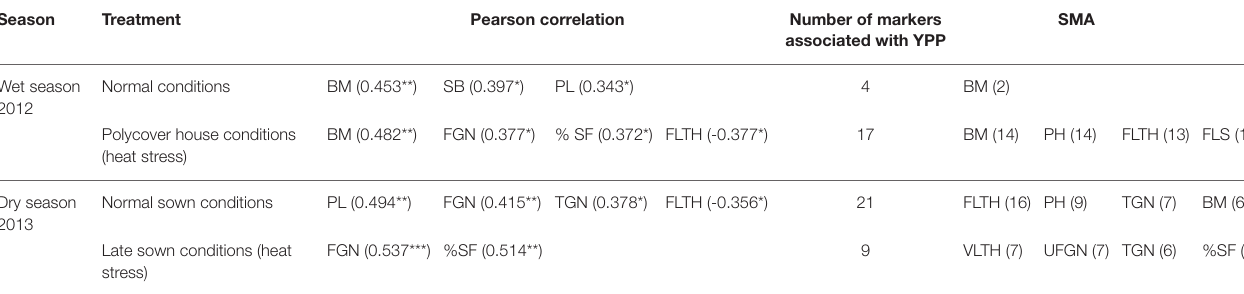
TABLE 4 | Correlation between grain yield and other agronomic and yield traits based on Pearson correlation and single marker analysis (SMA).